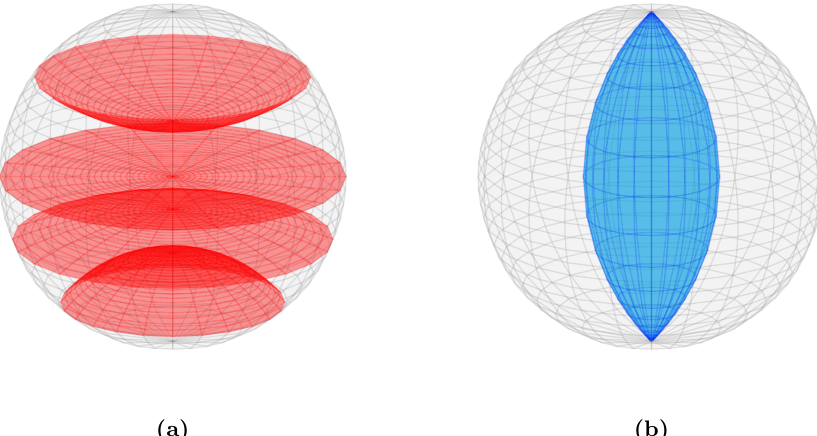
Figure 4 . Surfaces of (a) constant (cid:17) and (b) constant (cid:16) in the coordinate system for H 3 given by equations (2.8) and (2.9). The surface plotted are (a) (cid:17) = 0 : 7 ; 0 ; (cid:0) 0 : 4 ; (cid:0) 1 and (b) (cid:16) = 0 :